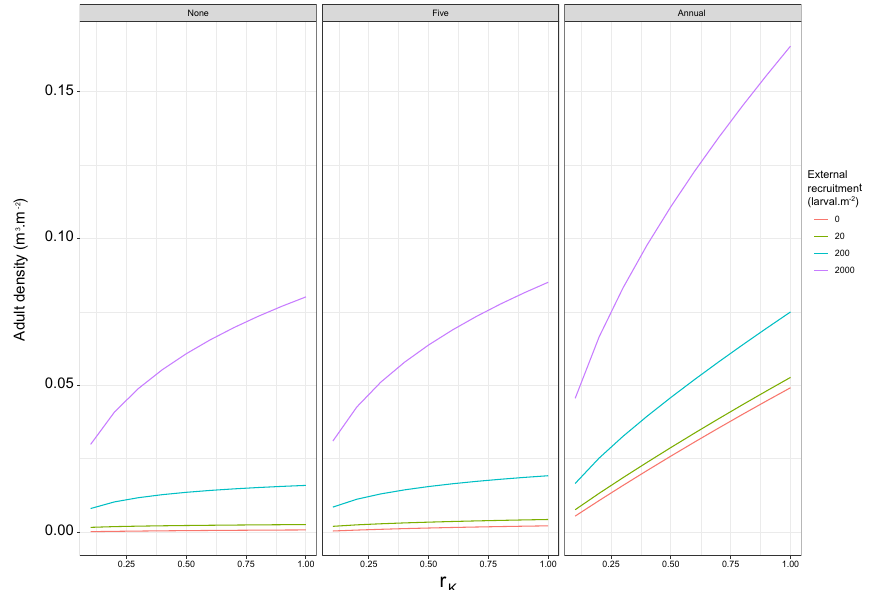
3 m − 2 ) at year 20 over r K , the carrying capacity 2 2 , green—R = 20 larvae m − , blue—R = 200